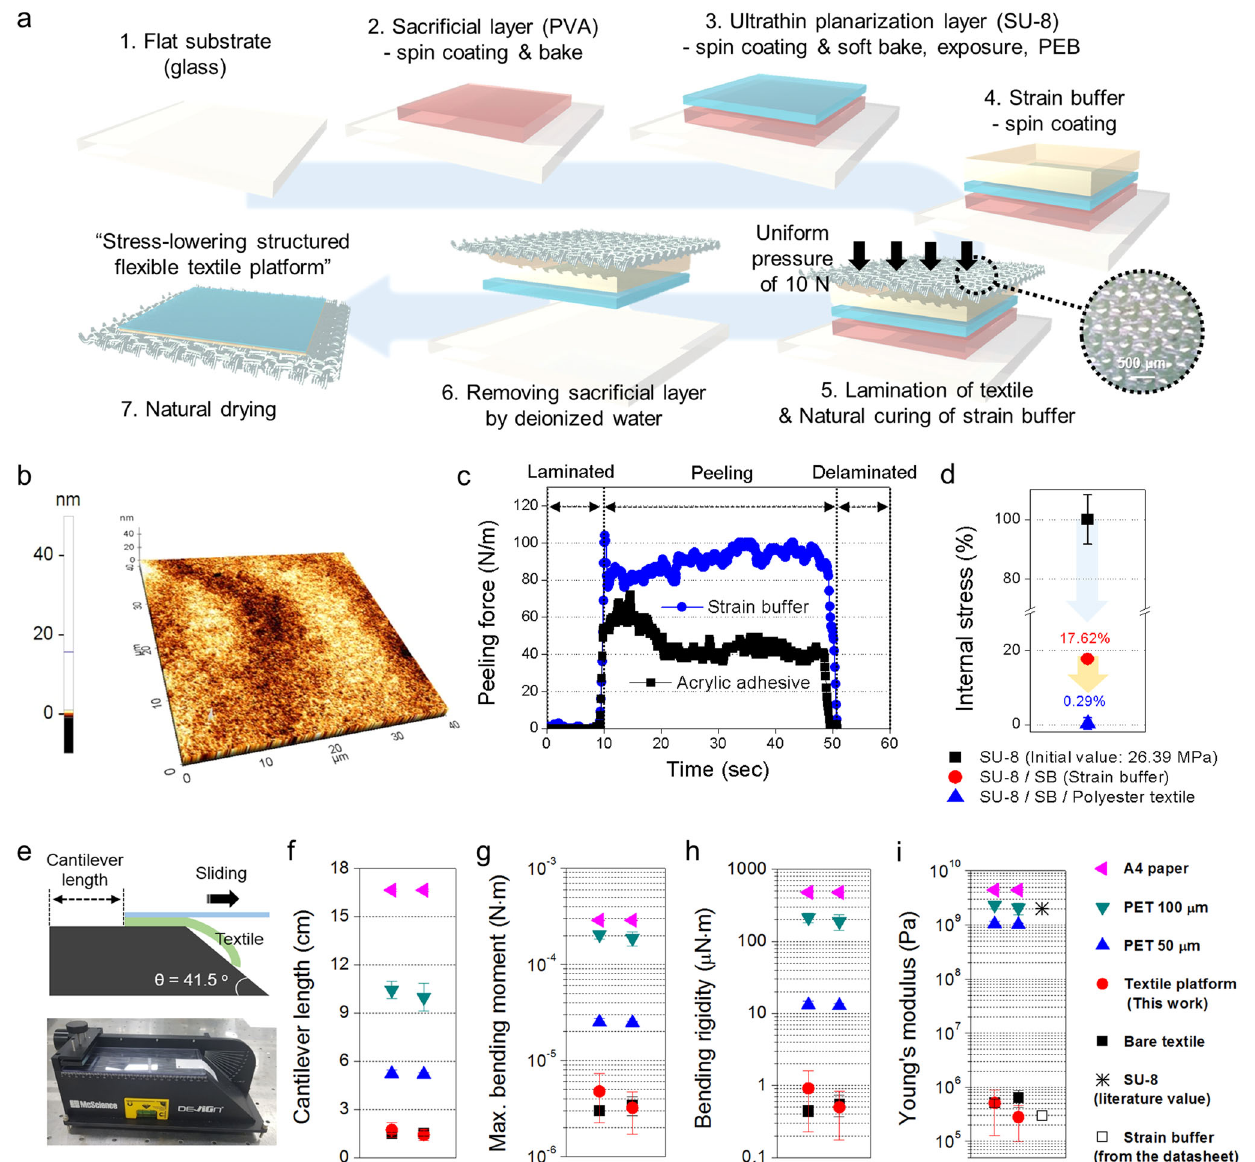
Fig. 1 Fabrication and mechanical characteristics of the textile platform. a Process fl ow for fabricating the textile platform. b Surface morphology of the textile platform measured by AFM. c Internal stress of the textile platform. d Force for peeling off the textile from the samples, consisting of acrylic tape and the textile (black square), and the SU-8, the strain buffer and the textile (blue circle). e Schematic diagram (up) and photograph (down) of the cantilever test, ASTM D:1388. f – i Cantilever lengths, bending moments, bending rigidity, and Young ’ s modulus obtained from the cantilever tests (with the error bars that mean standard